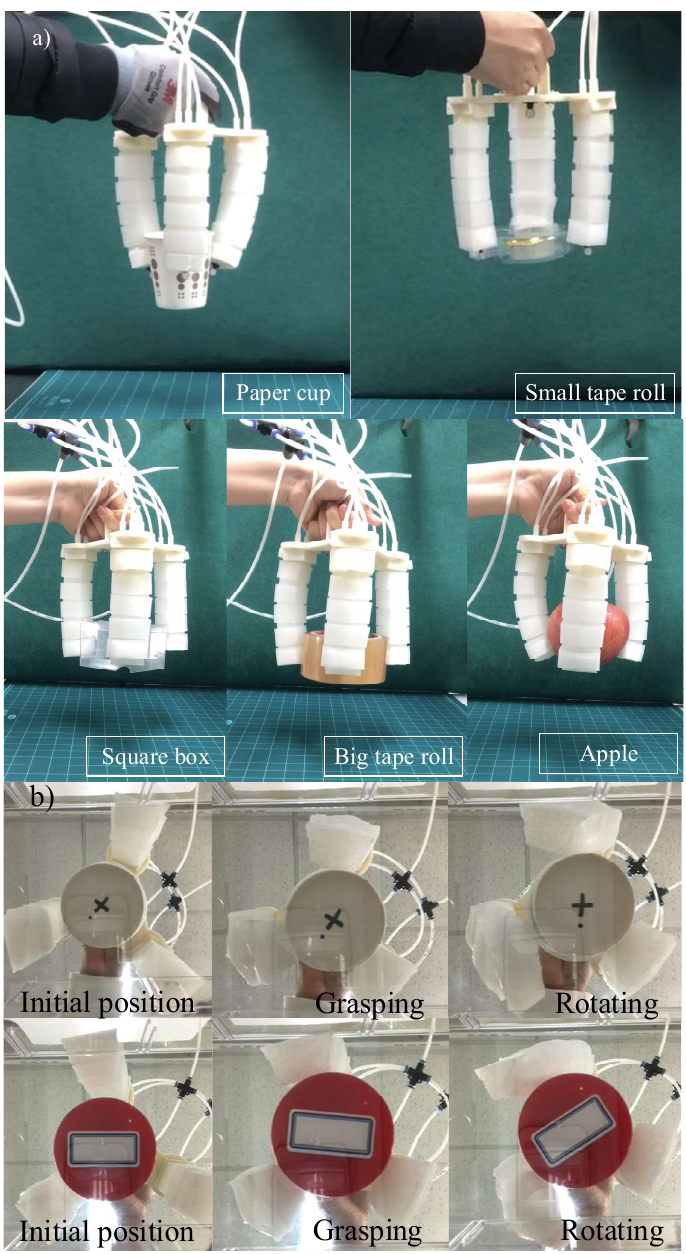
Figure 10. Grasping and twisting experiment: ( a ) Grasping performance without any object and grasping various objects; ( b ) bottom view during performance on twisting two different objects: Paper cup (0.004 kg) and red round box (0.05 kg).